Question: Condense the content of this figure into a single sentence.
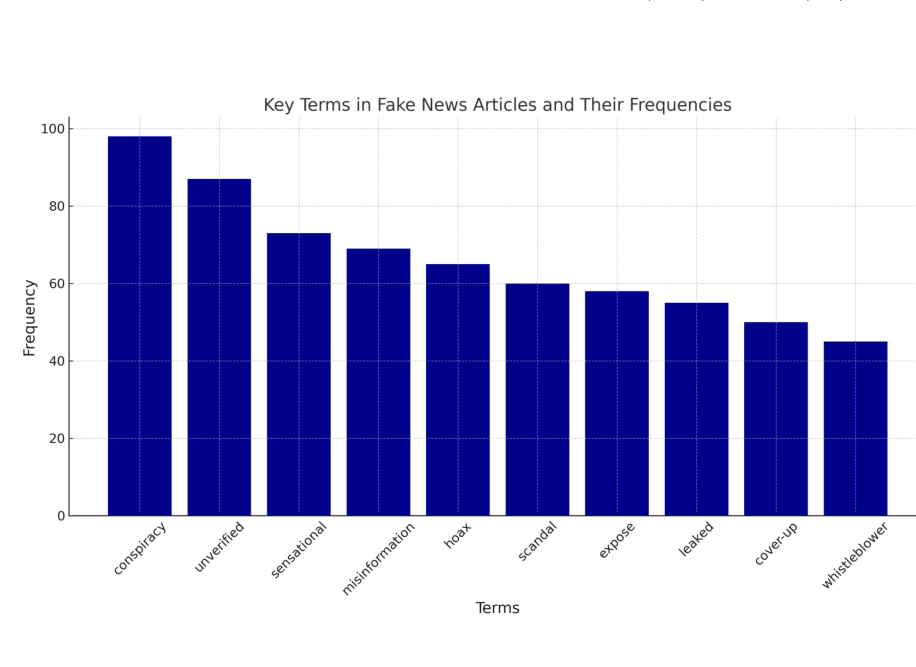
Answer: A bar chart of the frequency of each key term in the data.